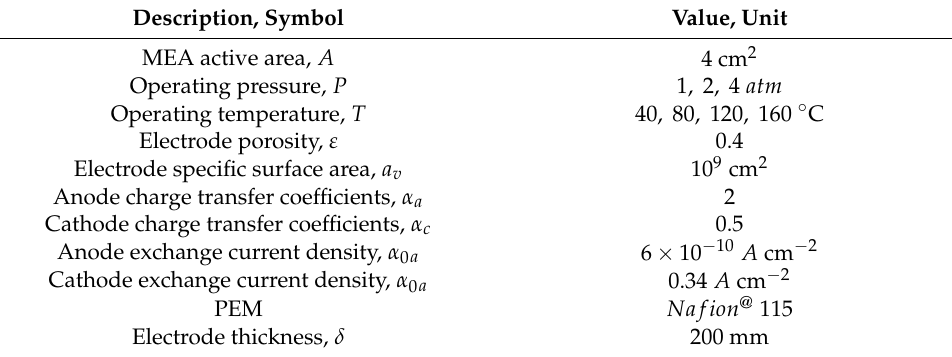
Table 1. Basic parameters used in the PEMEC modeling.